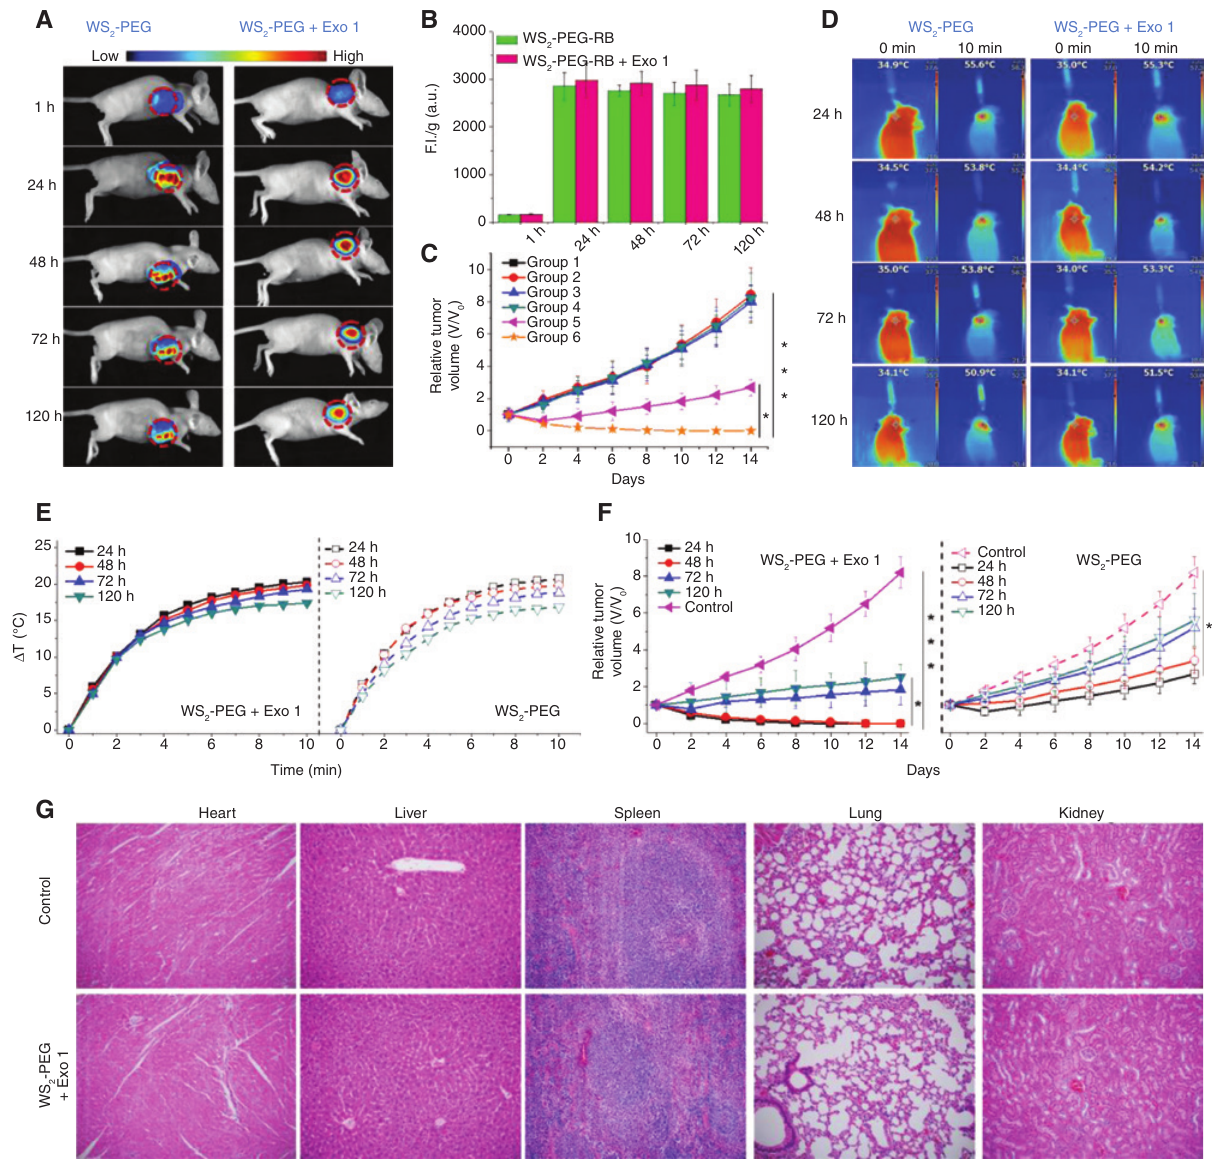
Figure 9: Enhanced photothermal therapeutic outcomes via blocking exocytosis in vivo . (A) Ex vivo fluorescence images of the tumor sites were taken from mice treated with NSs at different time points. (B) Quantitative analysis of the NSs in the tumors. (C) Tumor growth curves of mice with different kinds of treatments. Group 1: saline; Group 2: WS -PEG NSs; Group 2 3: WS -PEG NSs + Exo1; Group 4: Exo1 + NIR; Group 5: WS -PEG NSs + NIR; Group 6: WS -PEG NSs + Exo1 + NIR (WS -PEG NSs: 6 mg kg −1 , 2 2 2 2 intravenous injection; Exo1: 4 mg kg −1 , intratumoral injection). Twenty-four hours post injection, Groups 4, 5, and 6 were exposed to NIR radiation at tumor sites (808 nm, 0.5 W cm −2 , 10 min). (D) Photothermal images recorded by an IR thermal camera at a different time points. (E) Temperature changes at the tumor sites during the period of NIR irradiation. (F) Relative tumor volumes plotted between different groups. (G) H&E staining images of the major organs. Saline was used in the control